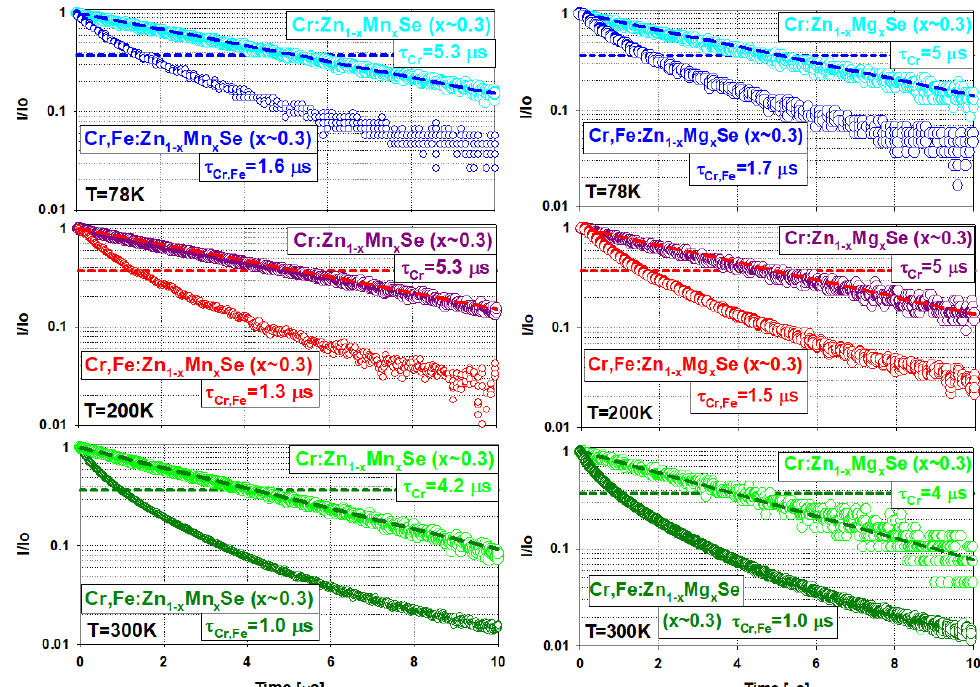
Figure 7. Temperature dependences of the Cr 2 + ions’ fluorescence decay time in Cr,Fe:Zn 1 − x Mn x Se (x ≈ 0.3) and Cr,Fe:Zn 1 − x Mg x Se (x ≈ 0.3) crystal under ∼ 1.73 µ m Q-switched laser excitation. τ Cr —Cr 2 + ions fluorescence lifetime of Cr 2 + -only doped crystal; τ Cr,Fe —Cr 2 + ions’ decay time at the 1/e level of Cr 2 + ,Fe 2 + co-doped crystal. Table 4. Temperature dependence of the Cr 2 + decay time in Cr 2 + ,Fe 2 + co-doped ( τ Cr,Fe , at 1/e level), and Cr 2 + ions’ lifetime ( τ Cr , measured at the tail) in Cr 2 + -only doped Zn 1 − x Mn x Se and Zn 1 − x Mg x Se (x ≈ 0.3) crystal samples under 1.73 µ m Q-switched laser excitation. The comparison of Cr 2 + → Fe 2 + energy transfer efficiencies calculated according to Equations (1) or (2). Temperature Crystal Sample, (K) x ≈